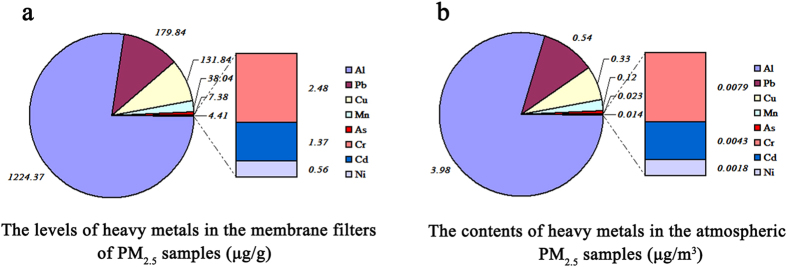
The measurements of heavy metal elements in atmospheric PM2.5 particles by ICP-MS during winter in tangshan city.The levels of heavy metals in the membrane filters of PM2.5 samples are shown in (a). The contents of heavy metals in the atmospheric PM2.5 samples are shown in (b). The eight kinds of heavy metal elements were displayed in order as Al > Pb > Cu > Mn > As > Cr > Cd > Ni.